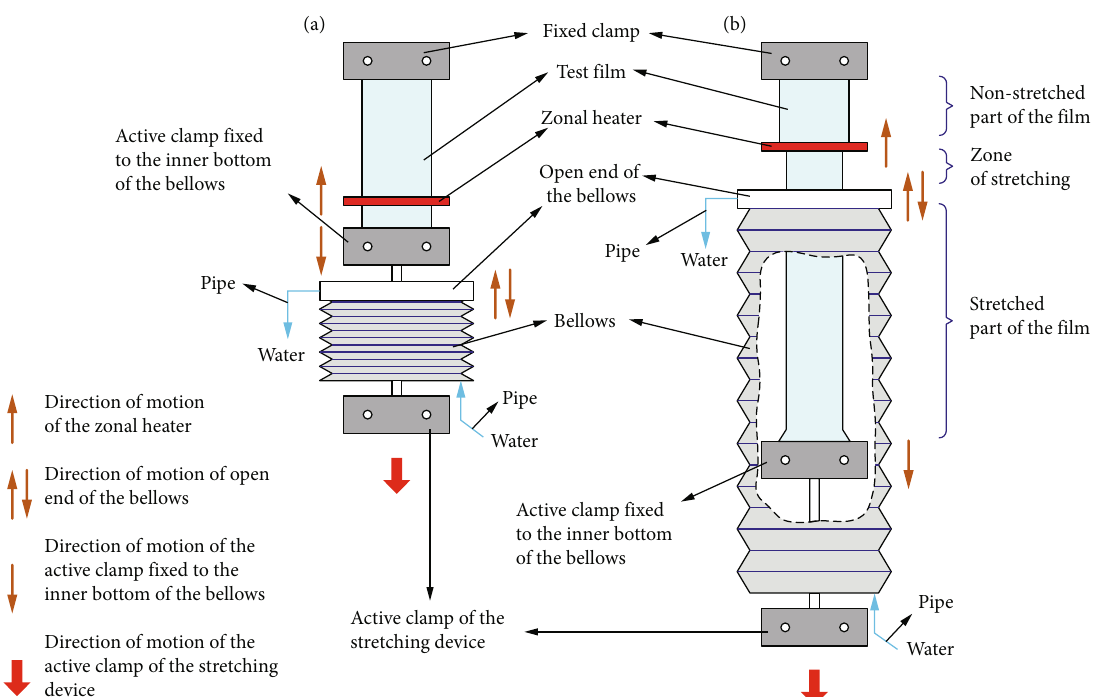
Figure 3: Scheme of using bellows with liquid for cooling the test sample during the stretching process: (a) initial state and (b) stretching